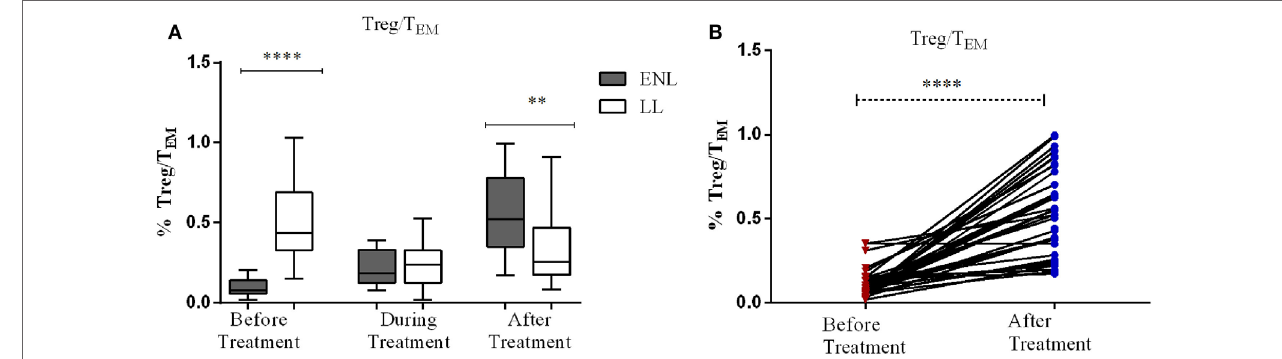
FigUre 8 | The median percentage of regulatory T-cells (T reg )/effector memory T-cells (T EM ) cells: (a) in patients with erythema nodosum leprosum (ENL) and lepromatous leprosy (LL) controls before, during, and after treatment, (B) within ENL patients before, during, and after treatment. ** P < 0.005; *** P < 0.001; **** P < 0.0001